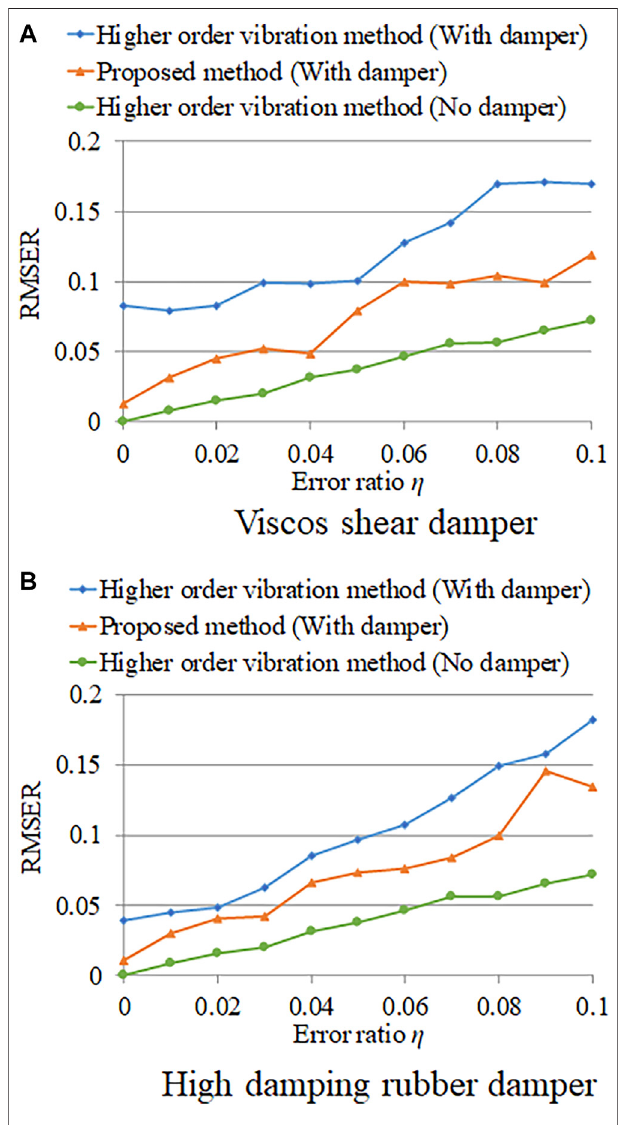
FIGURE 8 | Effect of measurement noise on estimation accuracy: (A) viscous shear damper; (B) high damping rubber damper.